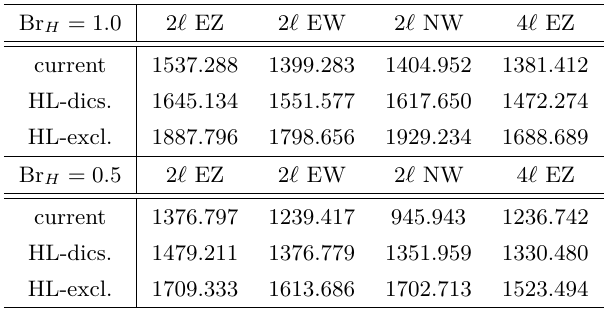
Table 6 . Lower bounds on the Higgs mass m H = m A in GeV, where Br H is the branching fraction of the corresponding decay mode of the Higgs boson. m e